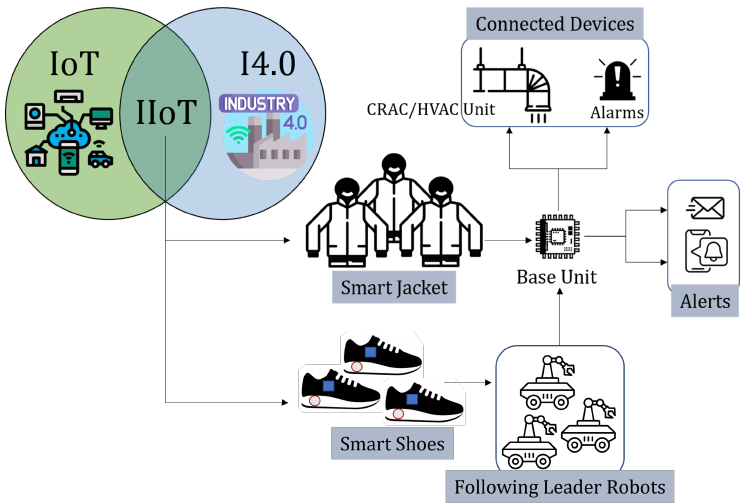
Figure 10. Smart Jacket and Smart Shoes in IoT and I4.0 for worker safety, protection, interaction, and detection of hazardous environment for alert and